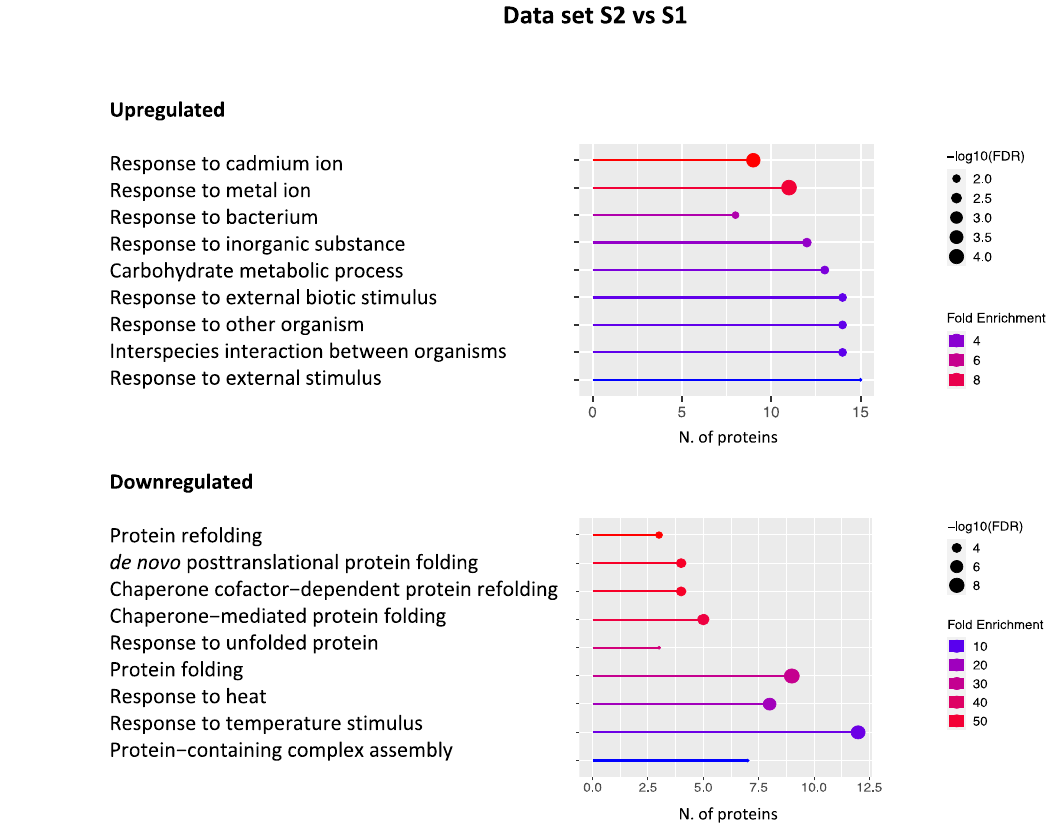
Figure 3. Graphical representation of the GO terms enriched in the S2 vs. S1 data set. The x -axis refers to the number of DEPs upregulated or downregulated that significantly enrich a specific GO term. Lines are colored by a red–blue gradient based on fold enrichment, whereas the size of the circle at the end of the lines is related to the statistical significance ( − log10 FDR).